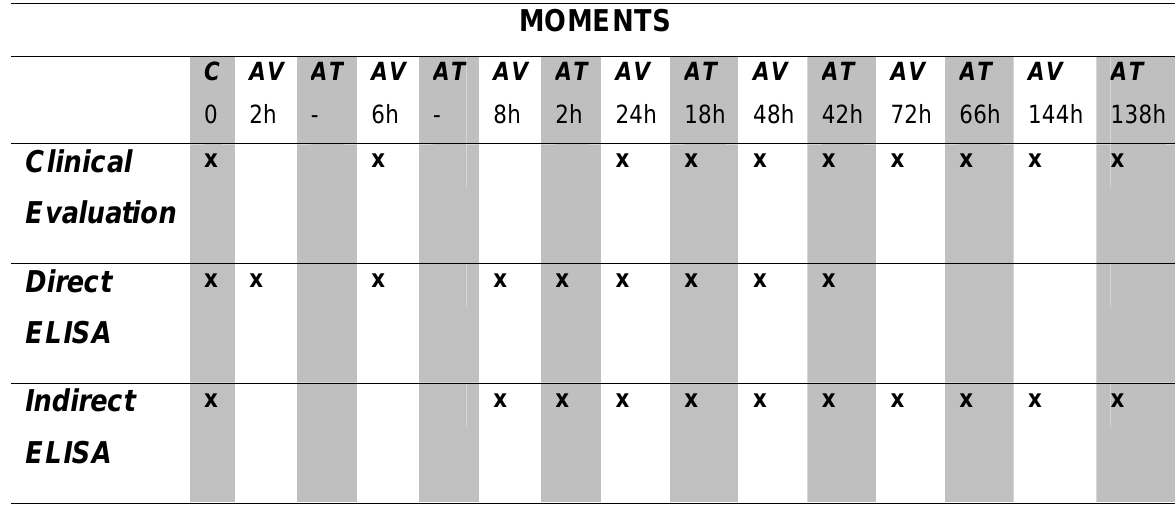
Table 1. Moments of clinical evaluation, venom quantification and antivenom